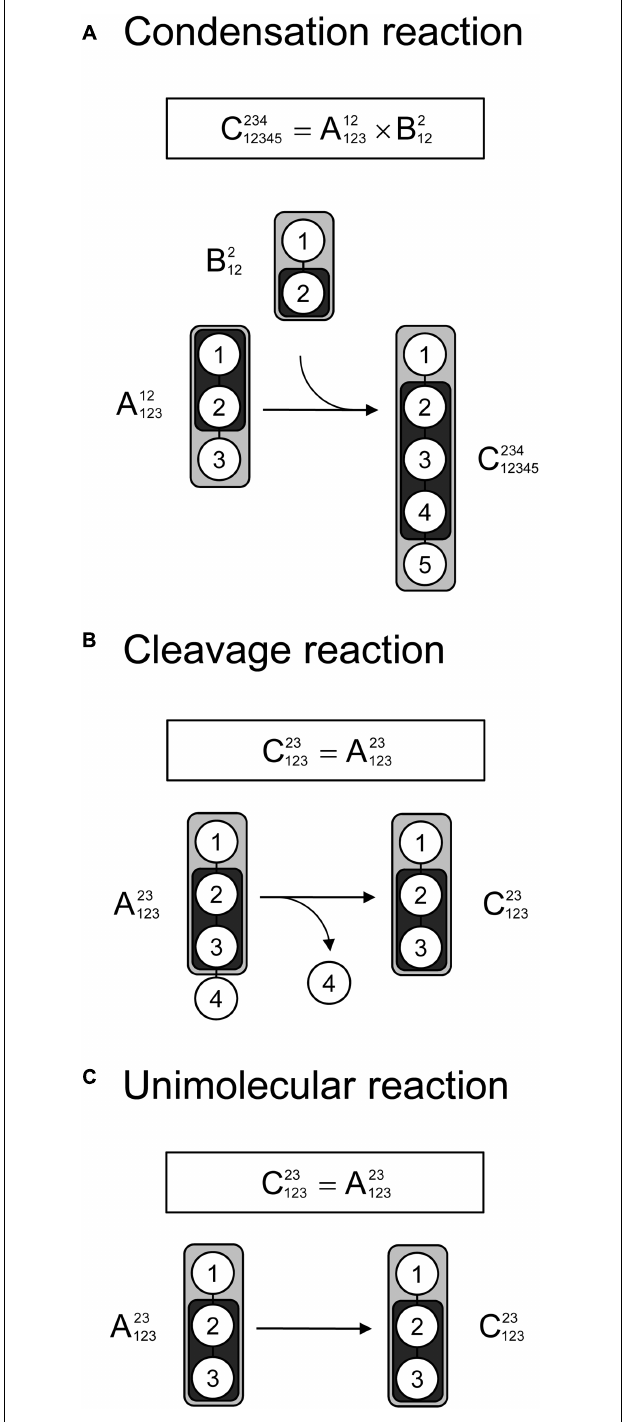
FIGURE 4 | Three types of biochemical reactions (A) condensation reaction, (B) cleavage reactions, and (C) unimolecular reaction, that must be considered for construction of EMU models. The labeling of an EMU product is expressed solely as a function of the labeling of the EMU educts. For the condensation reaction, the compact tandem MS matrix of the EMU product is calculated by 2D-convolution (denoted by “ × ”) of the compact tandem MS matrices of the EMU educts.